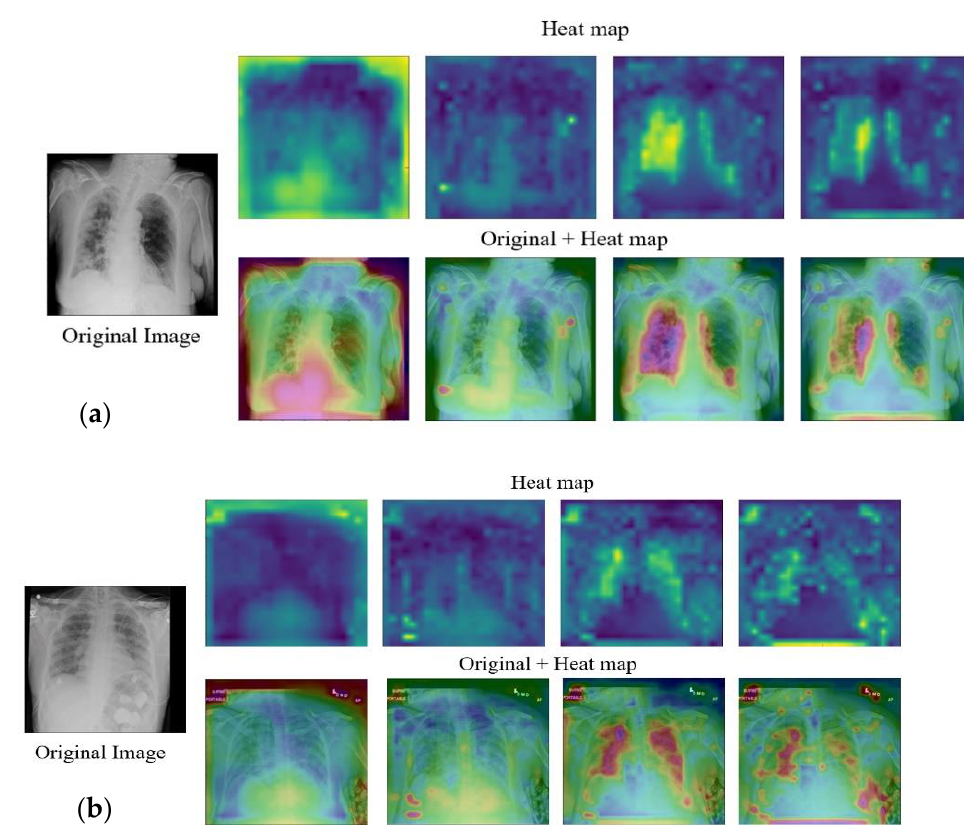
Figure 5. Heat maps of the COVIDx images: ( a ) COVID-19 and ( b ) pneumonia. Table 2. Classification results (expressed as a percent) obtained on the COVIDX dataset.